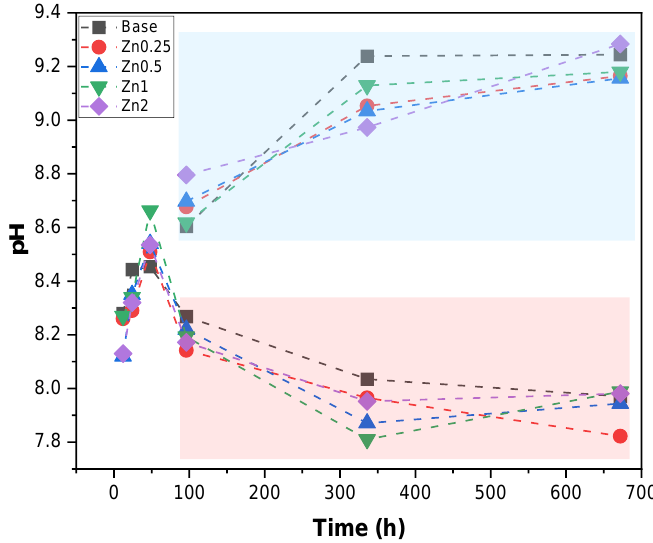
Figure 7. pH values of SBF medium after immersion of all samples for 12 h, 24 h, 48 h, 96 h, 336 h and 672 h. Red rectangle: medium change every two days; Blue rectangle: without medium change.